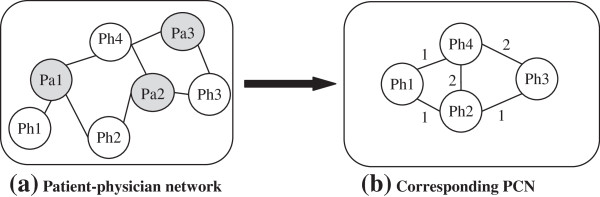
Conceptualisation of the collaboration network among physicians. (a) Patient-physician network, and (b) Corresponding PCN (Pa stands for patient, and Ph stands for physician.